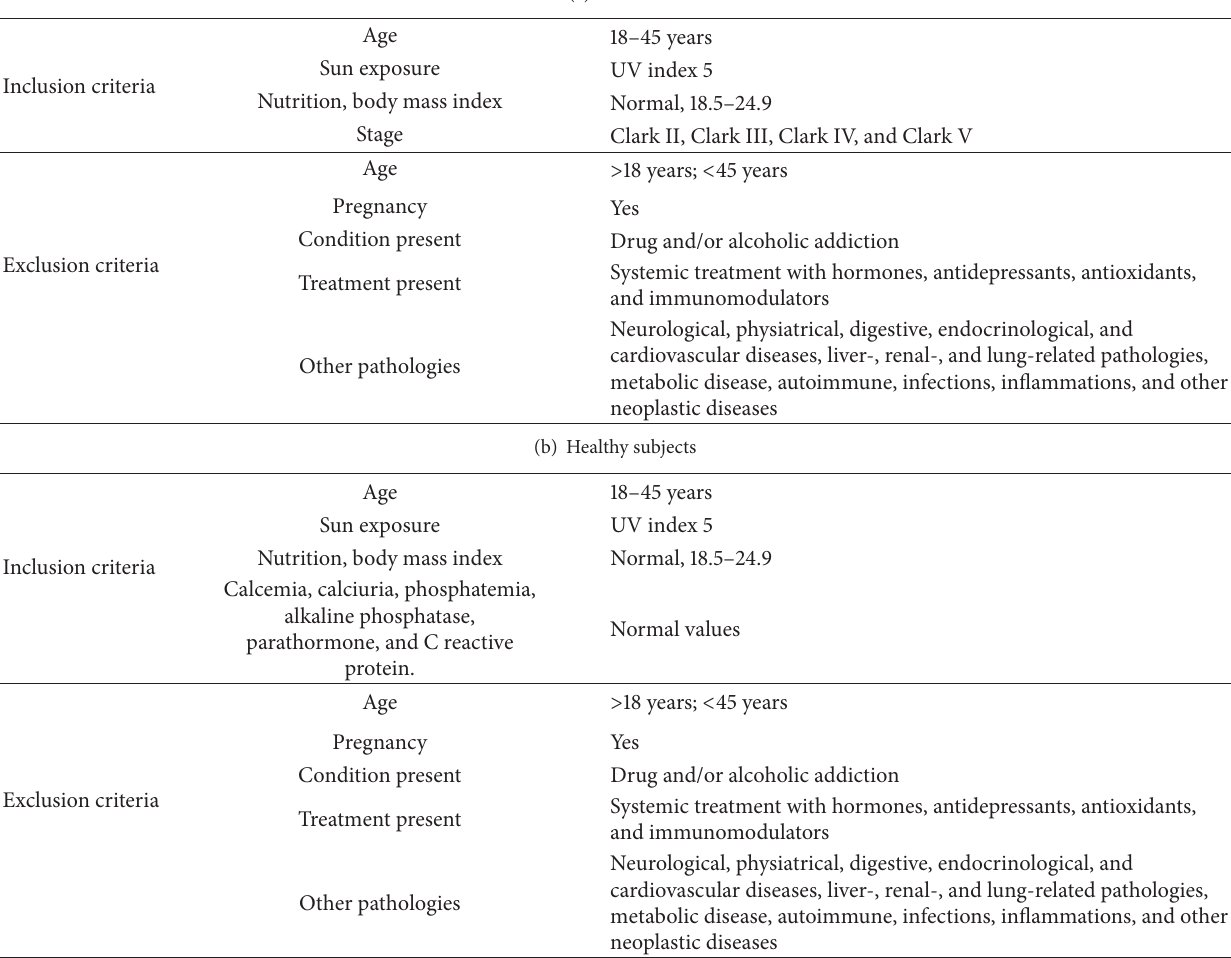
Table 1: Inclusion and exclusion criteria for patients (a) and healthy subjects